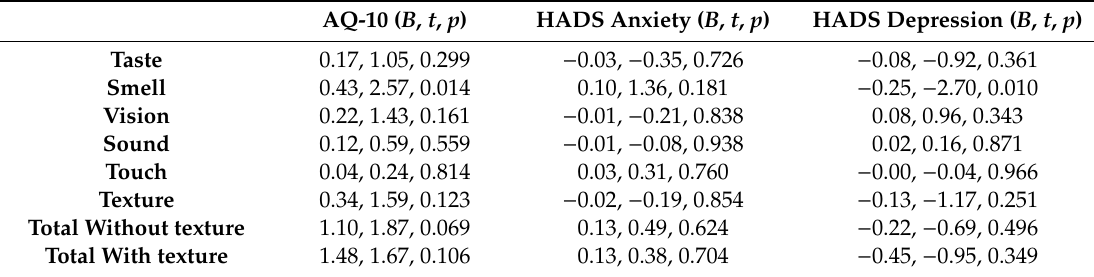
Table 3. Regression